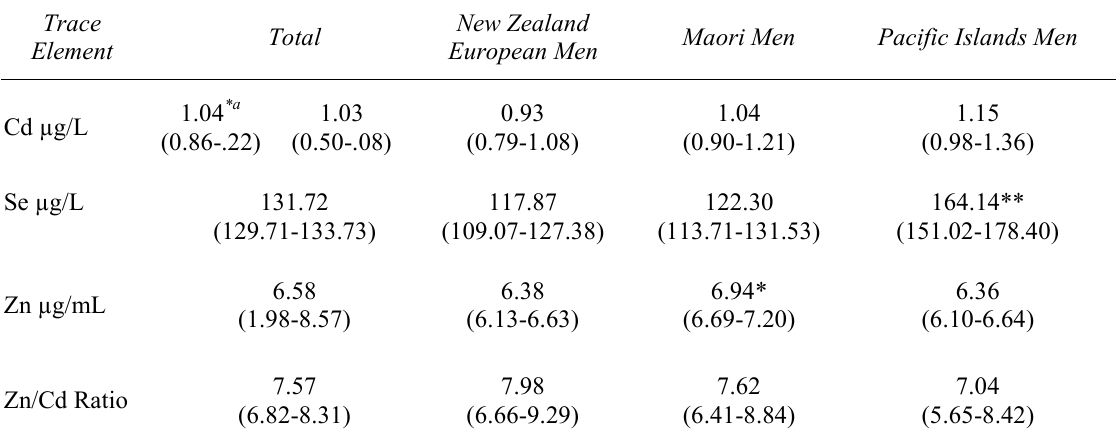
Table 2: Difference in blood trace element mean level between the three ethnic groups (p-value)